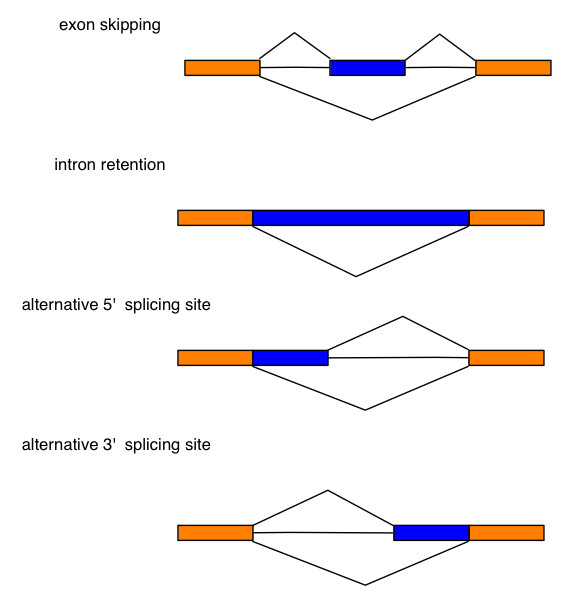
Four types of alternative splicing patterns: exon skipping, intron retention, alternative 5' splicing site, and alternative 3' splicing site.